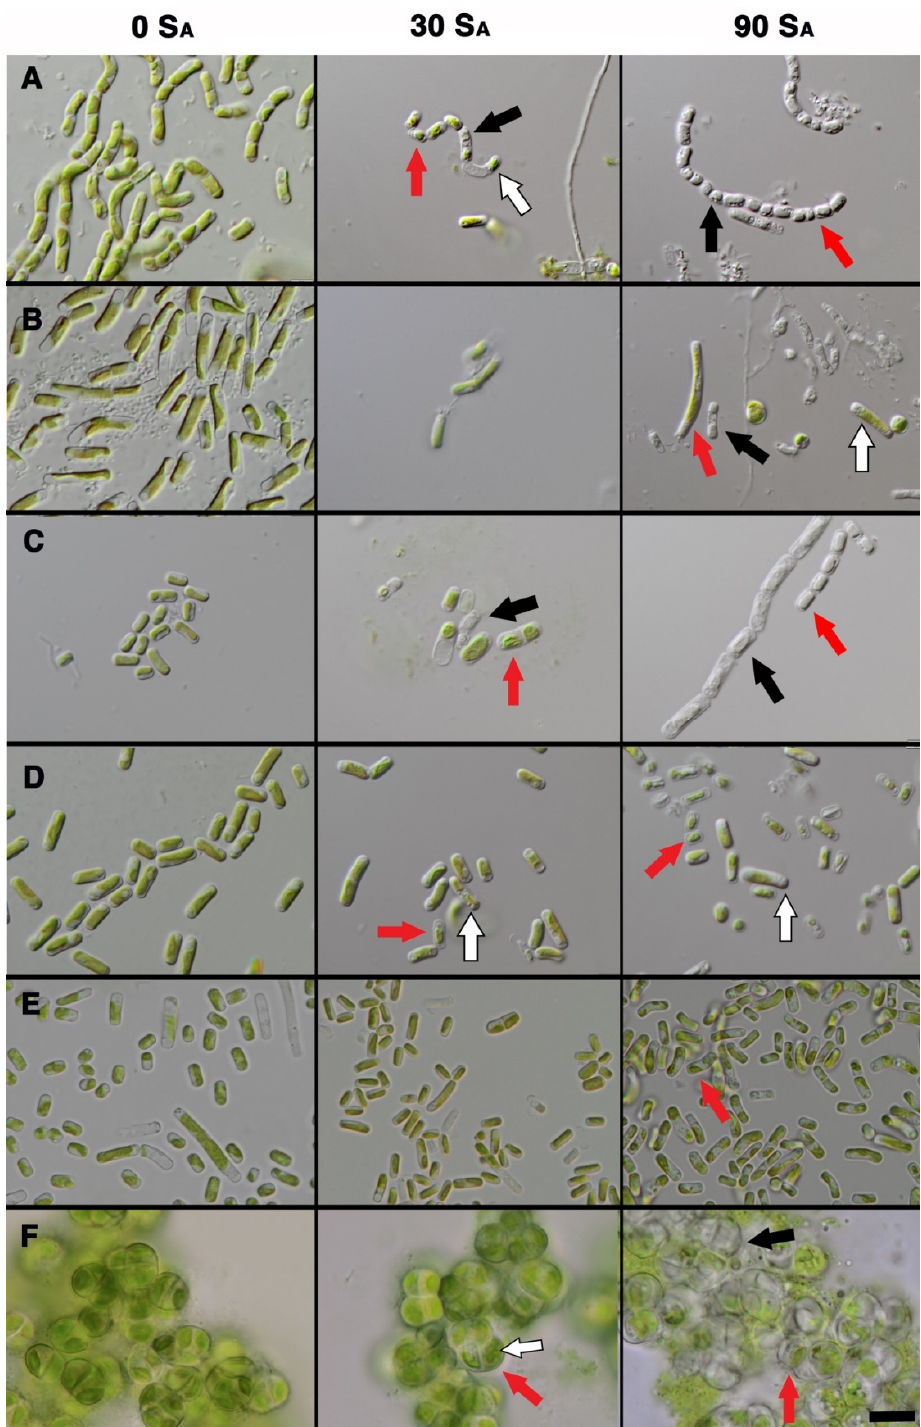
Figure 1. Morphological responses of selected strains in 0, 30, and 90 S A modified 3N BBM+V media after 8 weeks. Scale bar = 5 µm for all panels. ( A ) Deuterostichococcus tetrallantoideus ASIB-IB-37. ( B ) Pseudostichococcus sequoieti LB 1820. ( C ) Stichococcus bacillaris CCAP 379/1A. ( D ) Tetratostichococcus jenerensis J1302. ( E ) Pseudostichococcus monallantoides SAG 380-1. ( F ) Desmococcus olivaceus SAG 1.92. Red arrows indicate plasmolysis, black arrows chloroplast bleaching, and white arrows the accumulation of storage vacuoles. Most strains in the cohort were still able to thrive at 30 S A , but in halosensitive strains, there was already some bleaching and cell configuration changes present.